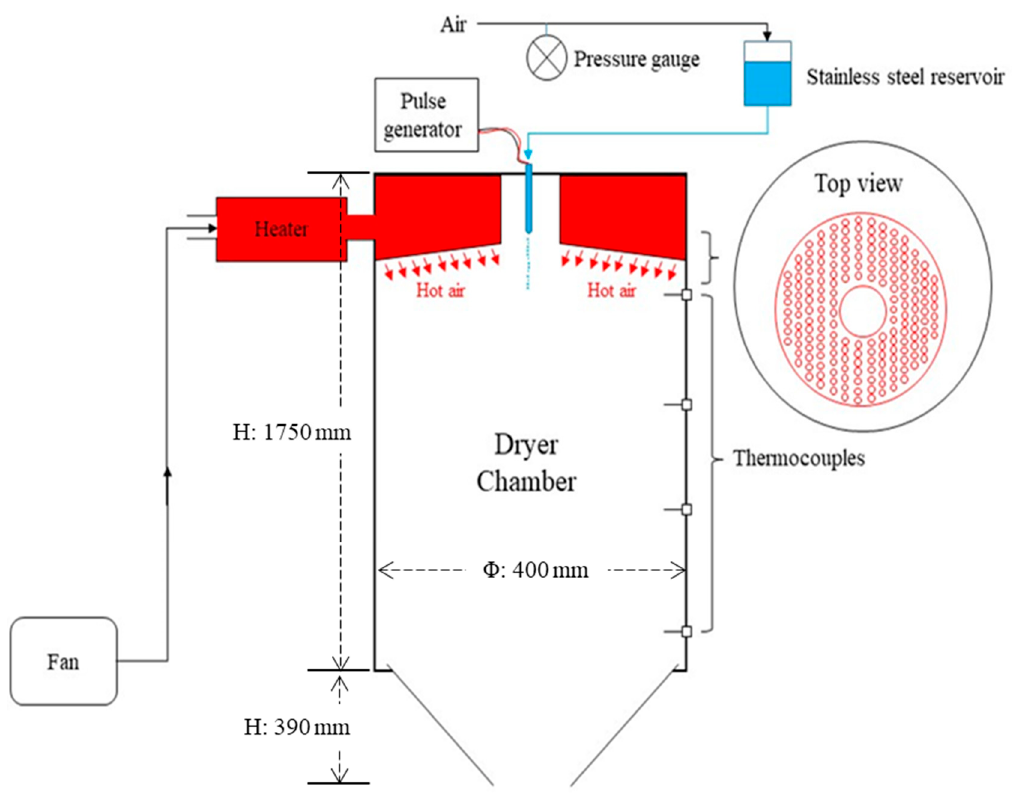
Figure A1. Schematic diagram of the micro-fluidic-jet-spray-dryer (MFJSD).